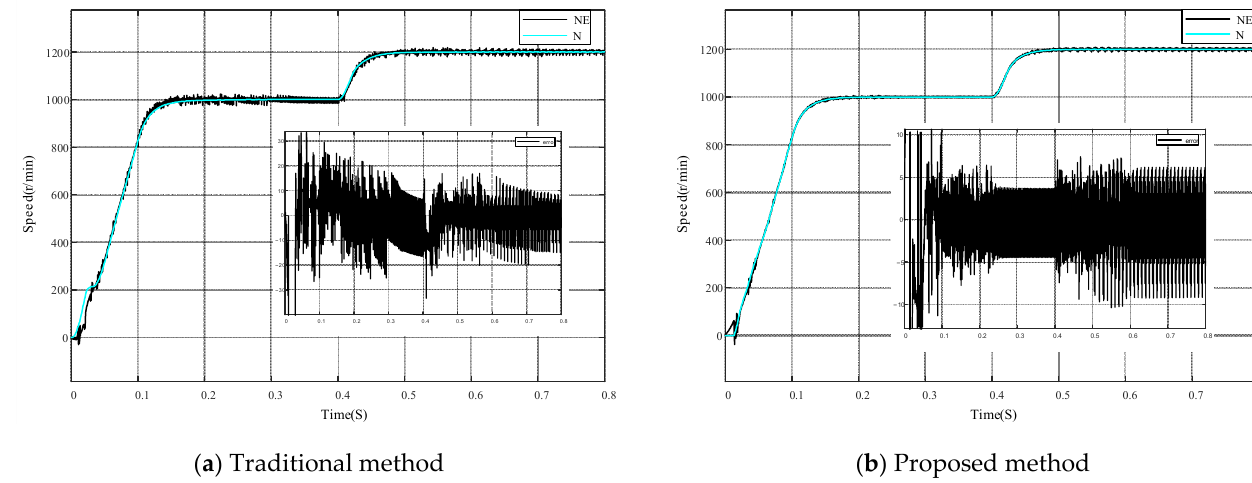
Figure 7. Waveforms of actual and estimated speeds from 1000 r/min to 1200 r/min. Figure 8 shows that when the motor runs stably at 1000 r/min, the motor load in- creases from 1.27 N.m to 2.54 N.m at 0.4 s. After the motor runs stably, the speed estima- tion error obtained by the traditional method changes from 10 r/min to 20 r/min. However, using the proposed method, the speed estimation error changes from 4 r/min to 6 r/min.